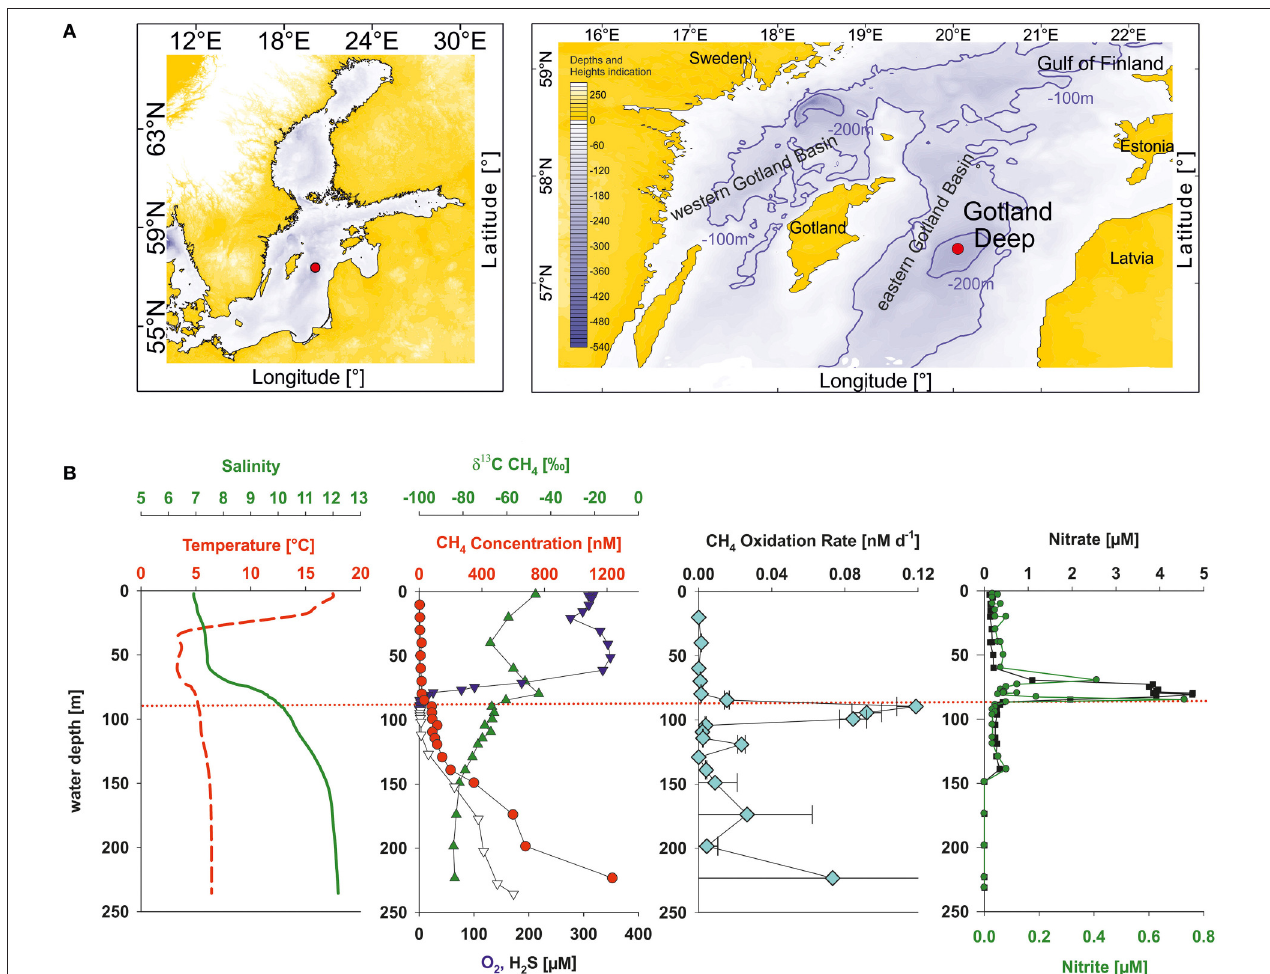
FIGURE 1 | (A) Sampling site (red circle) in the central Baltic Sea (eastern Gotland Basin). (B) Vertical profiles of temperature (red dashed line), salinity (green line), methane (red circles), δ 13 C values of methane (green triangles up), oxygen (blue triangles down), hydrogen sulfide (open triangles down), methane oxidation rates (light-blue diamonds), nitrate (black squares), and nitrite (green circles). The red dotted line shows the sampling depth of the bioreactor inoculum. All the data shown were obtained from water samples, taken on the same day and station as the sample for the bioreactor. The data -except nitrate and nitrite concentrations- were taken from Jakobs et al.